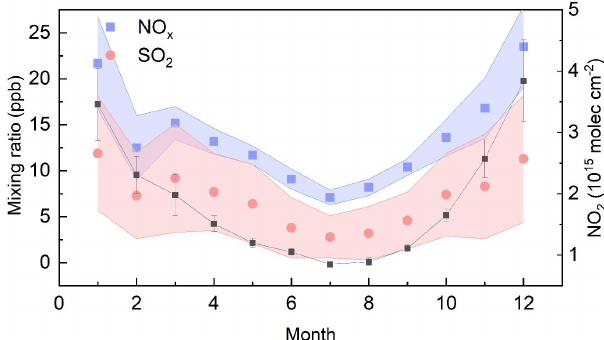
Figure 3. Monthly average NO x and SO 2 mixing ratios at LAN (left axis) and monthly tropospheric vertical column density of NO 2 (right axis) over 27.125–35.875 ◦ N, 115.125–122.875 ◦ E in the YRD during